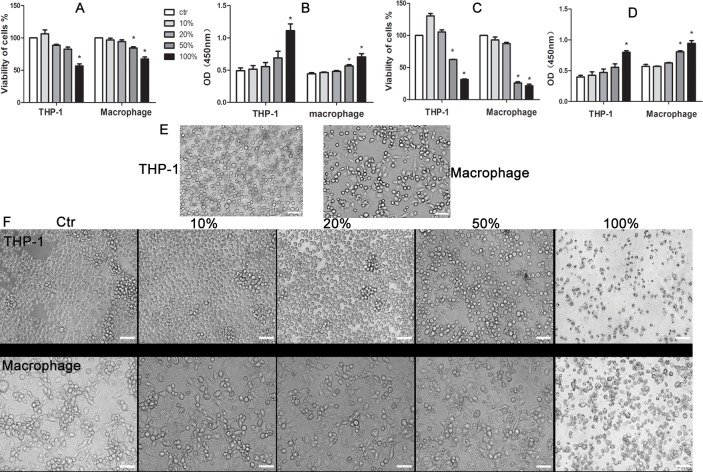
The effect of JDBM extracts cell viability of THP-1 cells and macrophages.CCK-8 test (A andC) and LDH tests (B andD) were assayed at 24h (A andB) and 72h (C andD). (E and F) Cytomorphology change of THP-1 cells and macrophages in the presence of JDBM extracts was observed at 0h and 72h. *P < 0.05 vs ctr. Abbrevations: ctr, control which was culture in RPMI 1640 medium. Scale bar = 100μm.